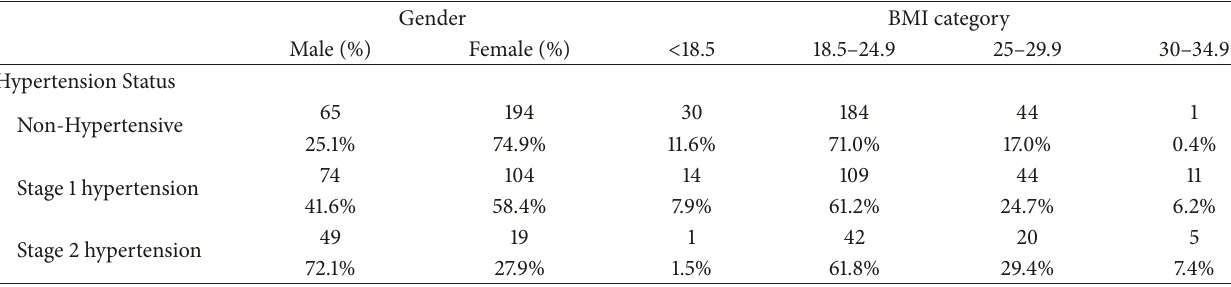
Table 3: Details regarding both gender differences and the difference in each BMI category with hypertension status.